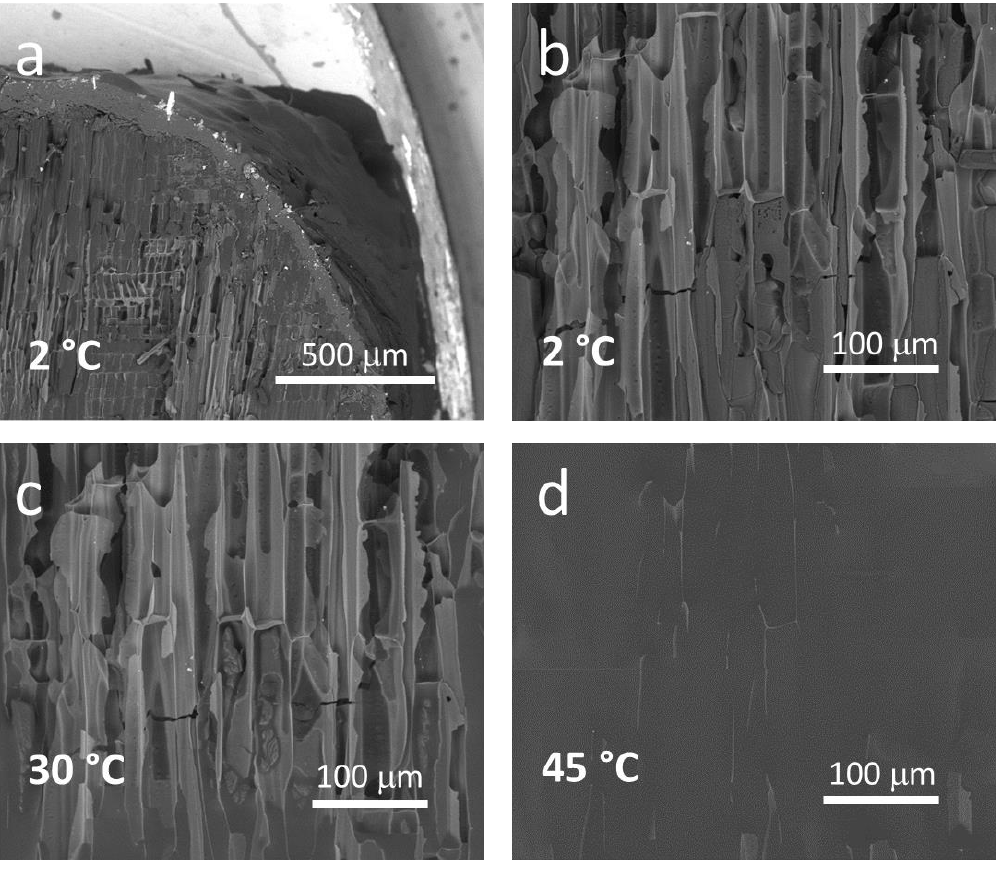
Figure 2. Temperature-dependent SEM images of the encapsulated carbonized wood – PCM (EN-CW–PCM) ( a ) a cross-section view. EN-CW–PCM morphology at different temperatures: ( b ) 2 ◦ C; composite (EN-CW – PCM) ( a ) a cross-section view. EN-CW – PCM morphology at different ( c ) 30 ◦ C; and ( d ) 45 ◦ temperatures: ( b ) 2 °C; ( c ) 30 °C; and ( d ) 45 °C.